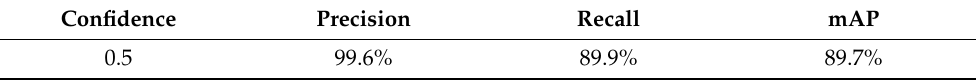
Table 2. Detection accuracy evaluation results of tailings ponds based on YOLOv4.